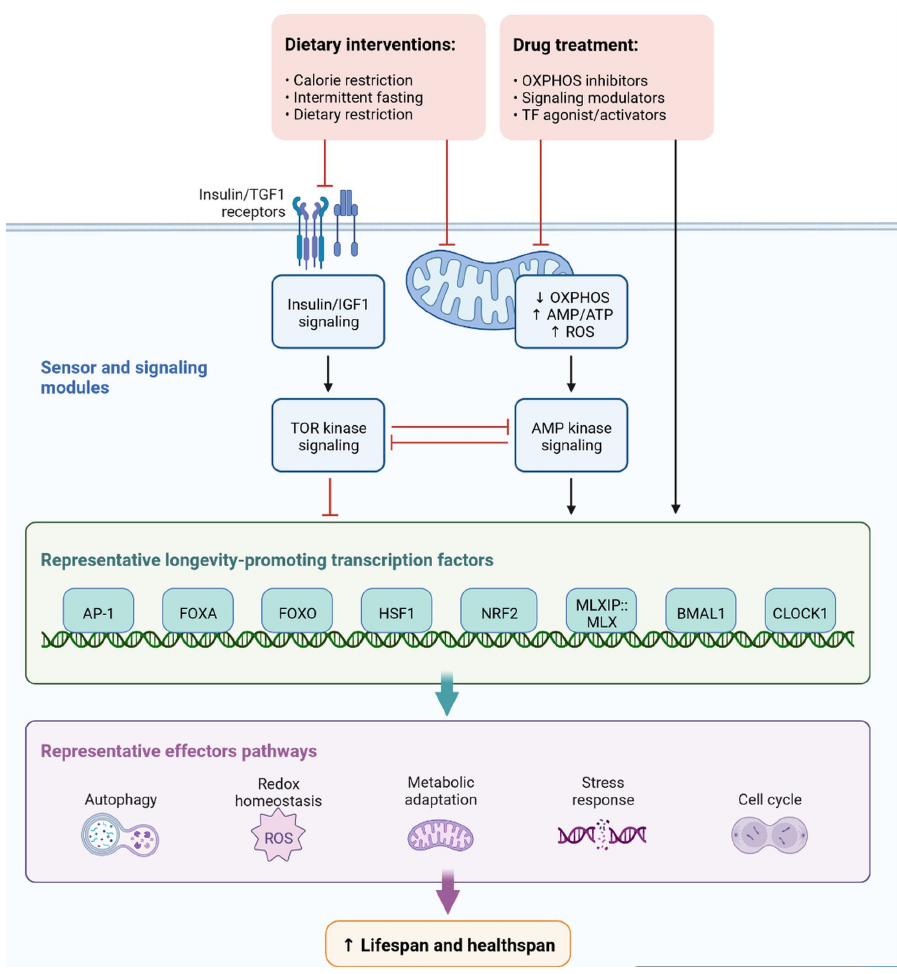
Figure 12. Representation of sensor and signaling molecule dietary intervention and treatment option regulated by effector pathways.